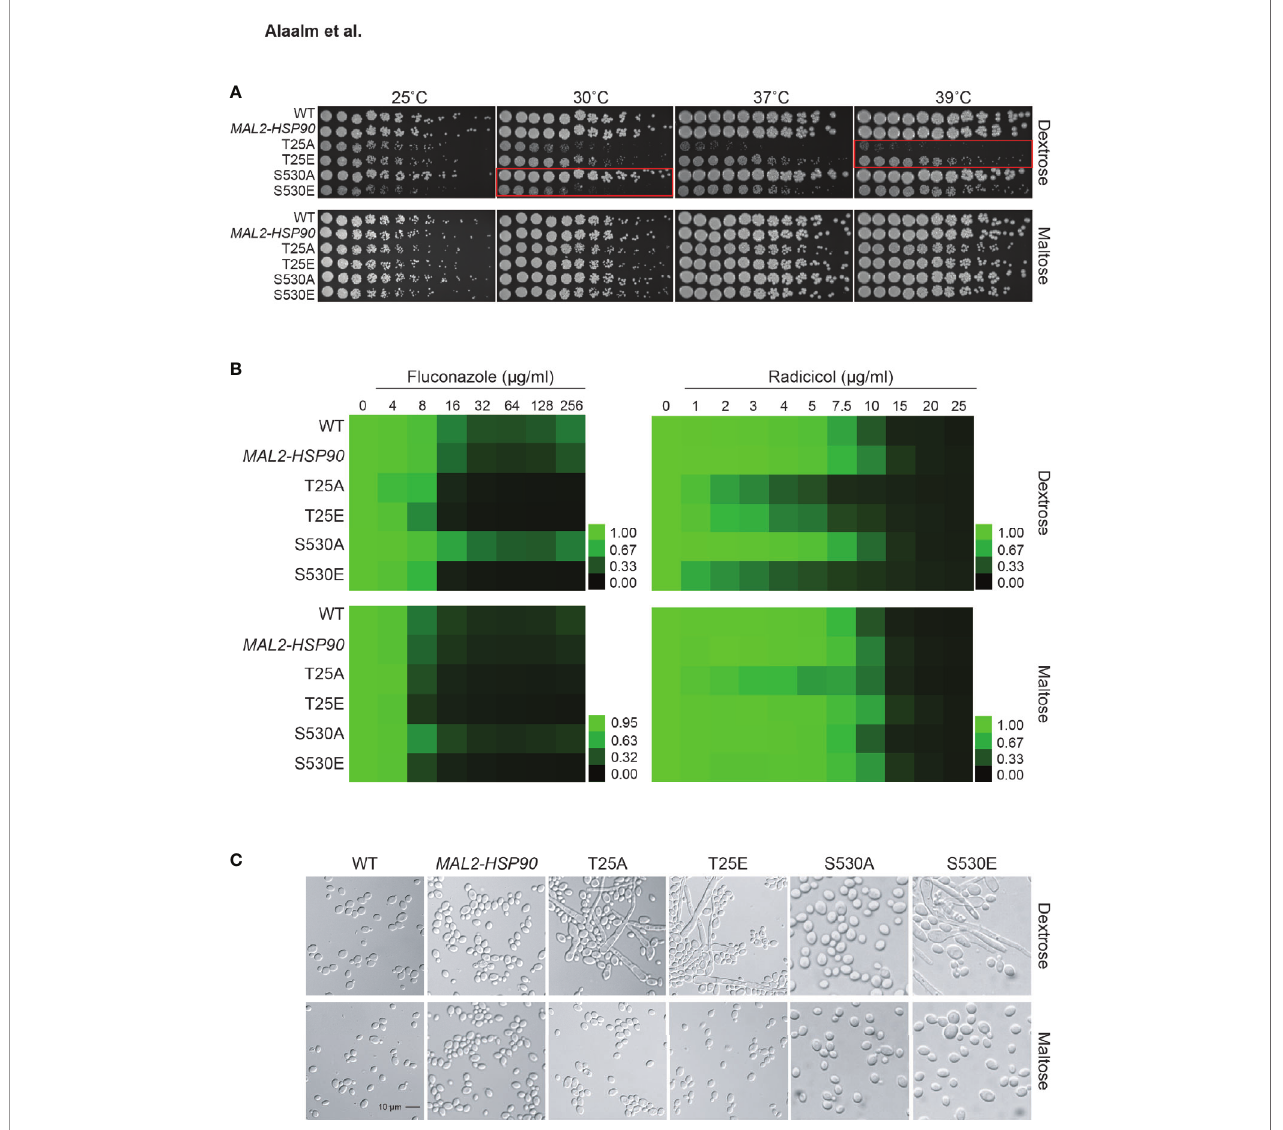
FIGURE 3 | Expression of key virulence traits is contingent on Hsp90 ’ s phosphorylation status. (A) Two-fold serial dilutions of the HSP90 wild-type, the MAL2- HSP90 promoter control strain, and hsp90 phospho-mutants were spotted onto solid media containing either dextrose or maltose and incubated at the indicated temperatures for 48 hours. Red boxes highlighting severe phenotypes. (B) Wild-type and mutant cells were exposed to increasing doses of the commonly employed antifungal drug fl uconazole and the Hsp90 inhibitor radicicol in media containing either dextrose (top) or maltose (bottom). Following incubation at 25 ˚ C, cell growth was assessed, normalized to the media only control and expressed as heat map where green indicates full growth and black represents no growth. (C) DIC microscopic images of representative cells from each strain con fi rming morphogenetic changes of cells grown in dextrose (top) but not maltose (bottom). Shown is one of two biological